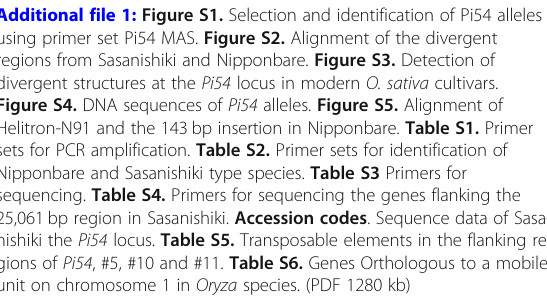
Figure S4. DNA sequences of Pi54 alleles. Figure S5. Alignment of Helitron-N91 and the 143 bp insertion in Nipponbare. Table S1. Primer sets for PCR amplification. Table S2. Primer sets for identification of Nipponbare and Sasanishiki type species. Table S3 Primers for sequencing. Table S4. Primers for sequencing the genes flanking the 25,061bp region in Sasanishiki. Accession codes . Sequence data of Sasa- nishiki the Pi54 locus. Table S5. Transposable elements in the flanking re- gions of Pi54 , #5, #10 and #11. Table S6. Genes Orthologous to a mobile unit on chromosome 1 in Oryza species. (PDF 1280 kb) Abbreviations AA: Amino acid; BAC: Bacterial artificial chromosome; CC: Coiled-coil domain; CDS: Coding DNA sequence; CNV: Copy number variation; CTAB: Cetyl trimethylammonium bromide; LRR: Leucine-rich repeats domain; NBS: Nucleotide-binding site domain; R-gene: Resistance